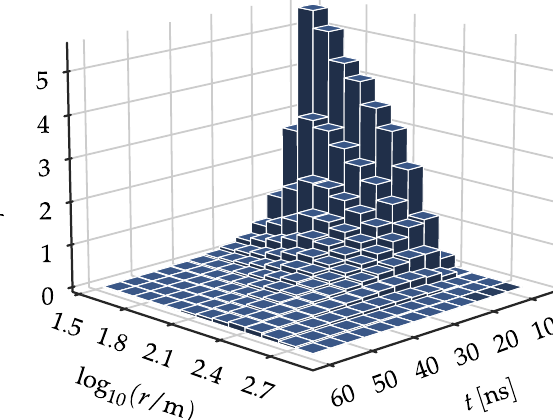
Fig. 5 Average number of muons per time-bin as a function of the logarithm of the distance to the shower axis (measured on the shower plane) and of the shower plane arrival time. The average corresponds to proton air-showers with 18 . 0 ≤ log 10 ( E / eV ) ≤ 18 . 2 and 27 ◦ (cid:2) θ (cid:2) 33 ◦ (0 . 20 ≤ sin 2 θ ≤ 0 .